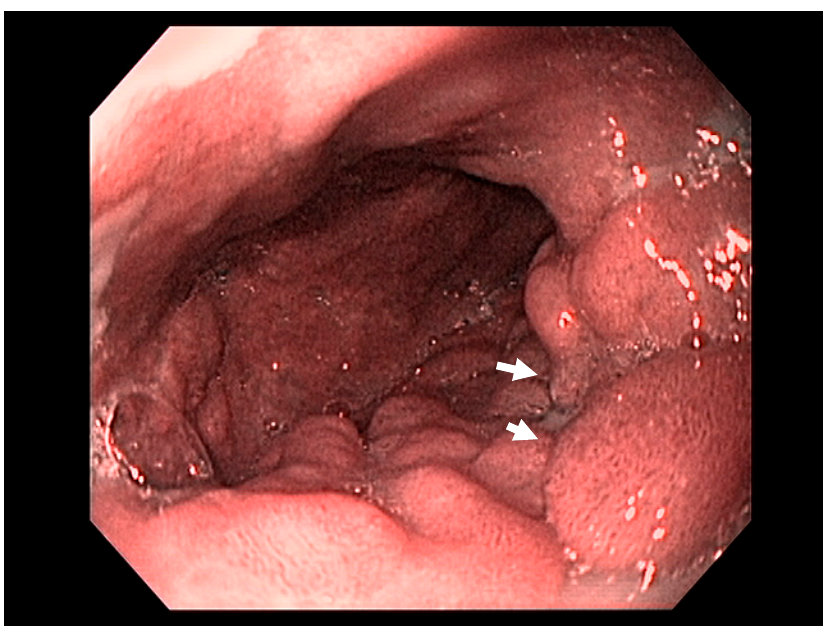
Figure 2. Barrett’s esophagus with nodules under narrow band imaging (NBI) (arrows).